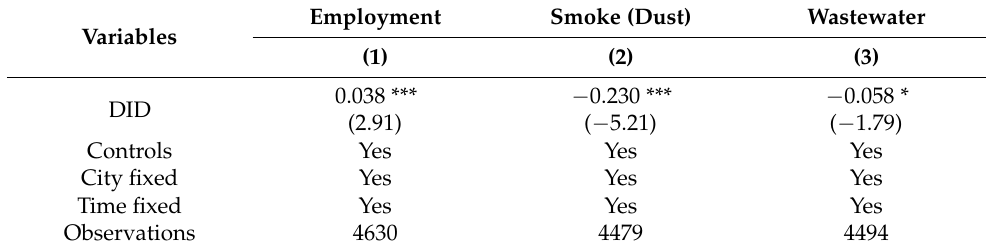
Table 4. Baseline regressive